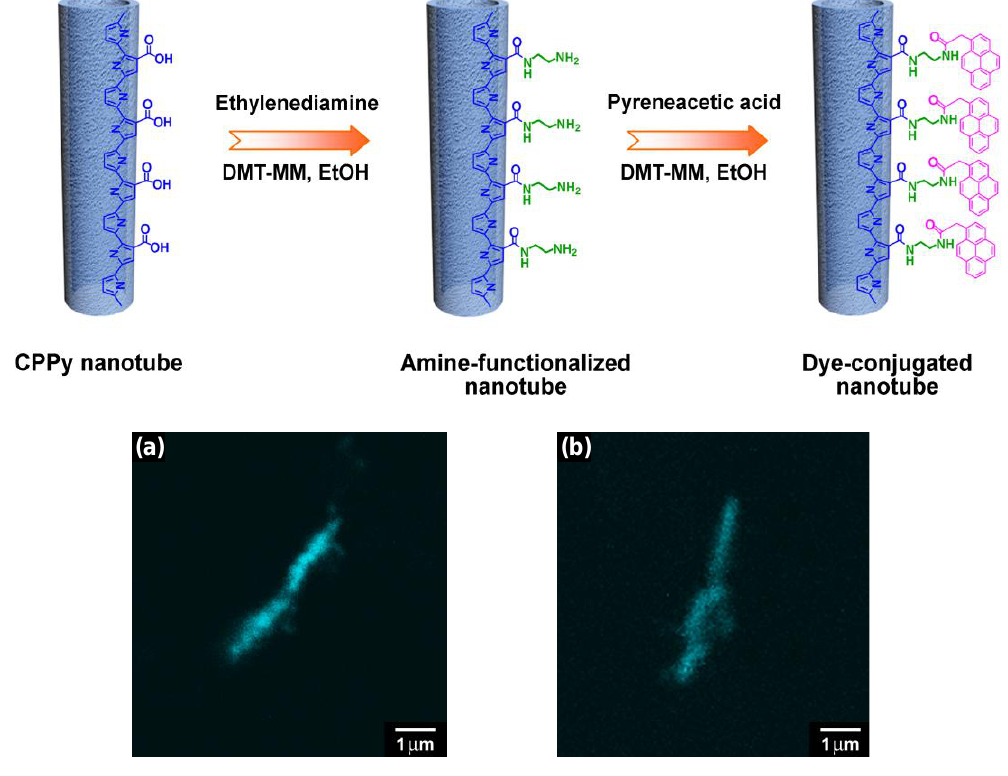
Figure 1. Schematic illustration of reaction steps for the covalent immobilization